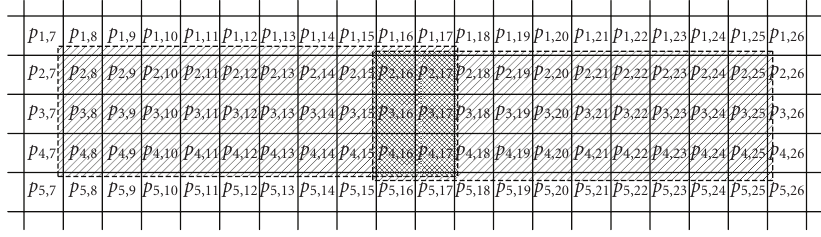
Figure 12: The content of Data Window in two consecutive steps (assume the kernel size is 3 × 3 and D is 8).